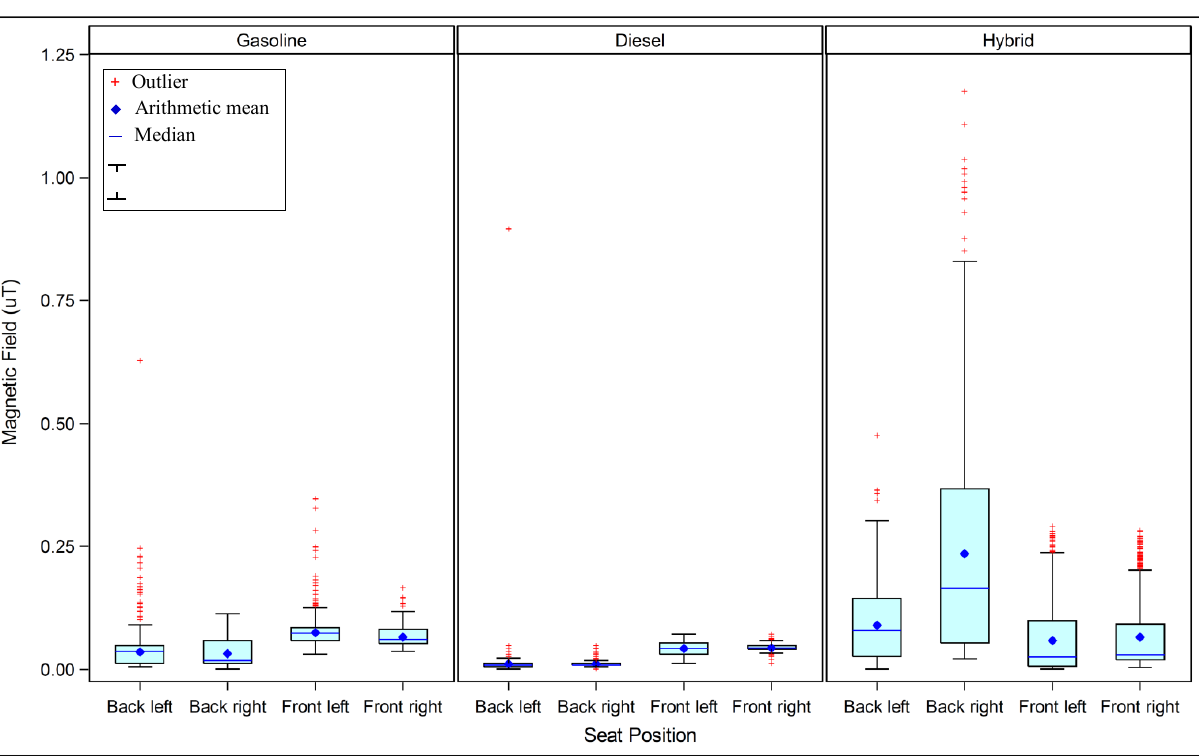
Figure 3. Magnetic field measurement by seat position, stratified by engine